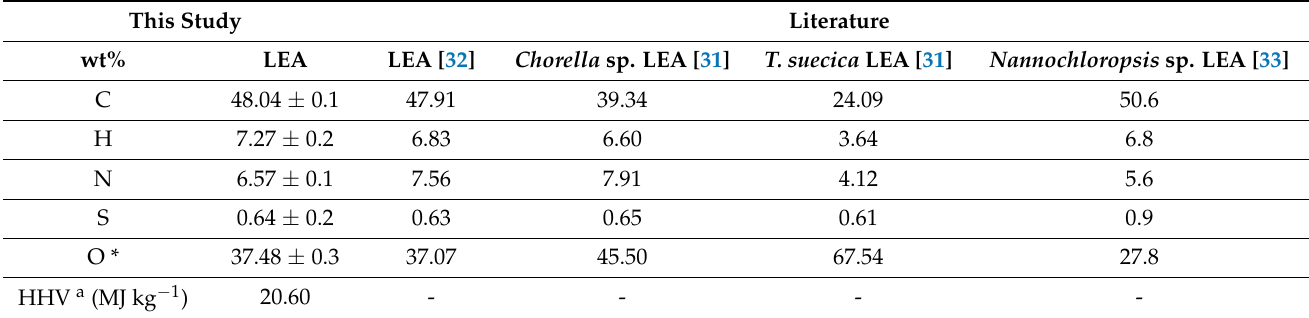
Figure 1. Proximate analysis based on LEA on TG and DTG curves at 15 °C/min heating rate. Table 2. Ultimate analysis data for LEA.